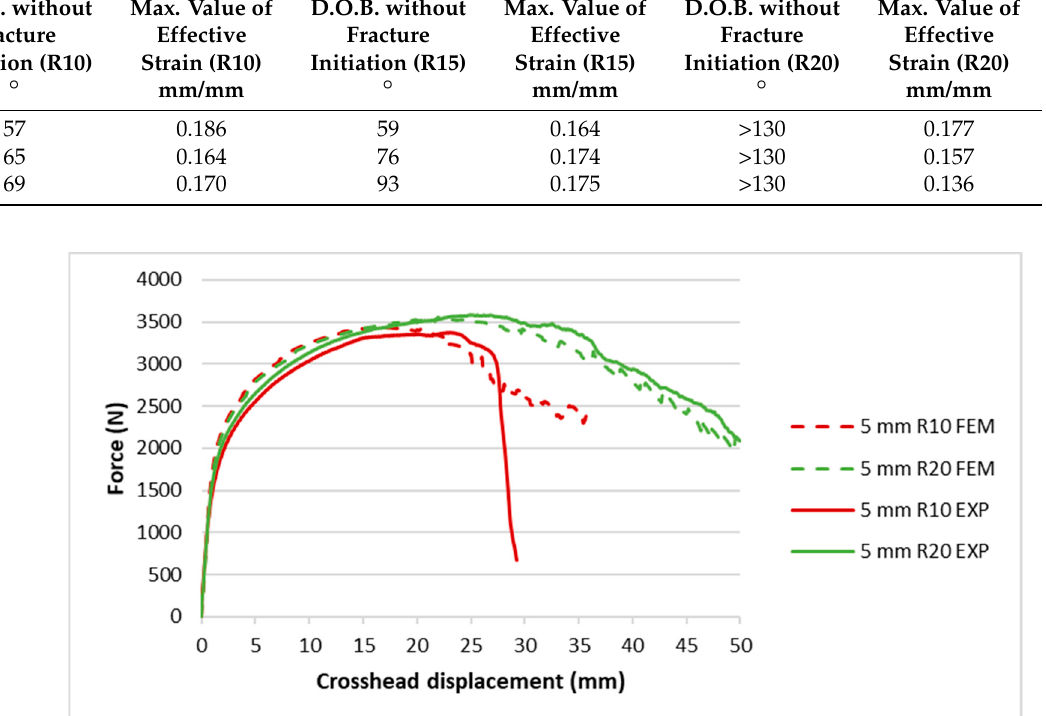
Figure 7. The correlation between FEM predicted and the experimentally measured relation between the force and the cross-head displacement for 5 mm sheet.